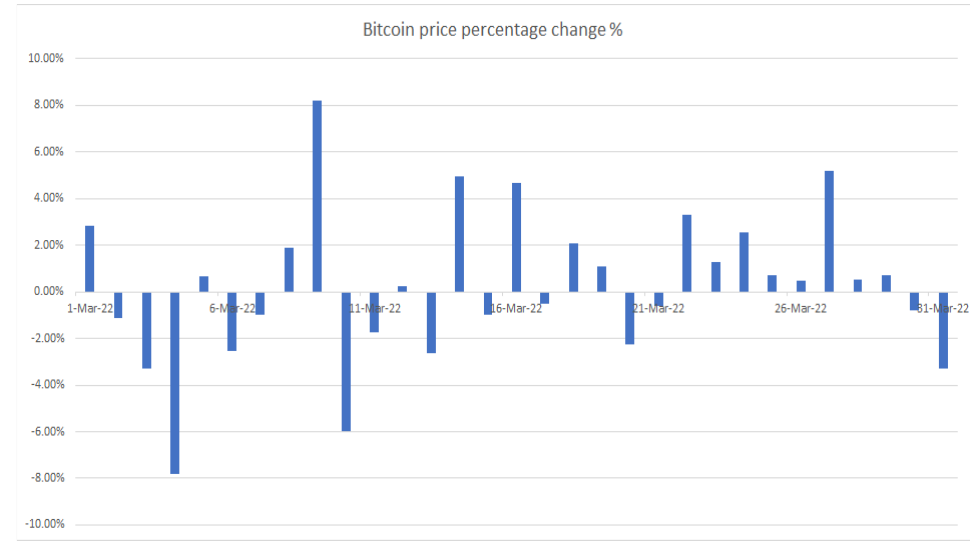
Figure 4. March 2022 percentage change of Bitcoin price.